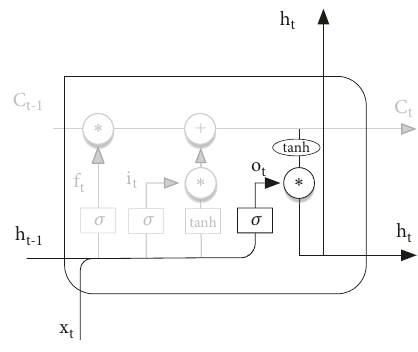
Figure 3: LSTM decision output layer.